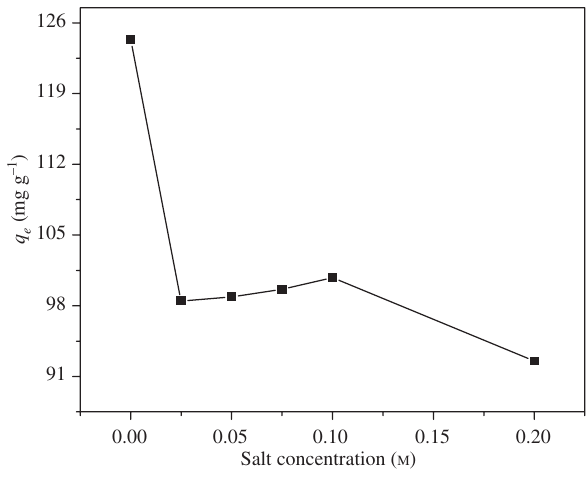
Figure 9: Effect of ionic strength on the adsorption of MB by Fe O /C-CAA microspheres at pH 11 and 25 ° C. 3 4